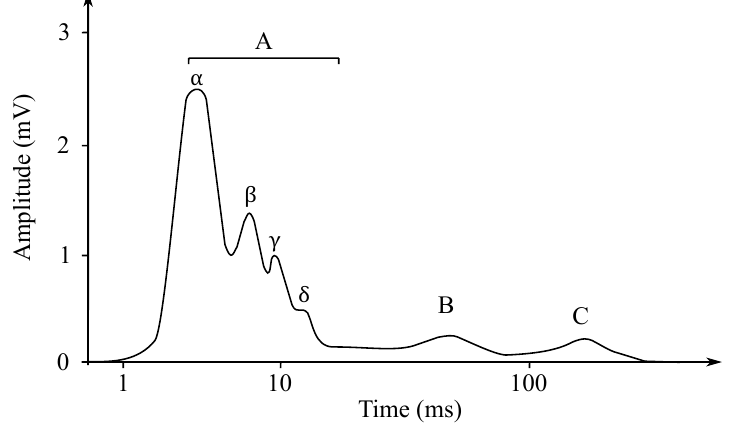
Figure 4. The ENG mixed nerve.